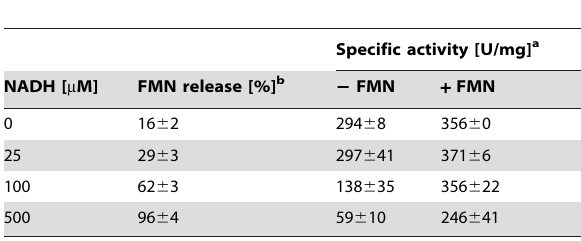
Table 2. NADH-mediated reduction leads to the release of FMN and concomitant inactivation of the HoxFU